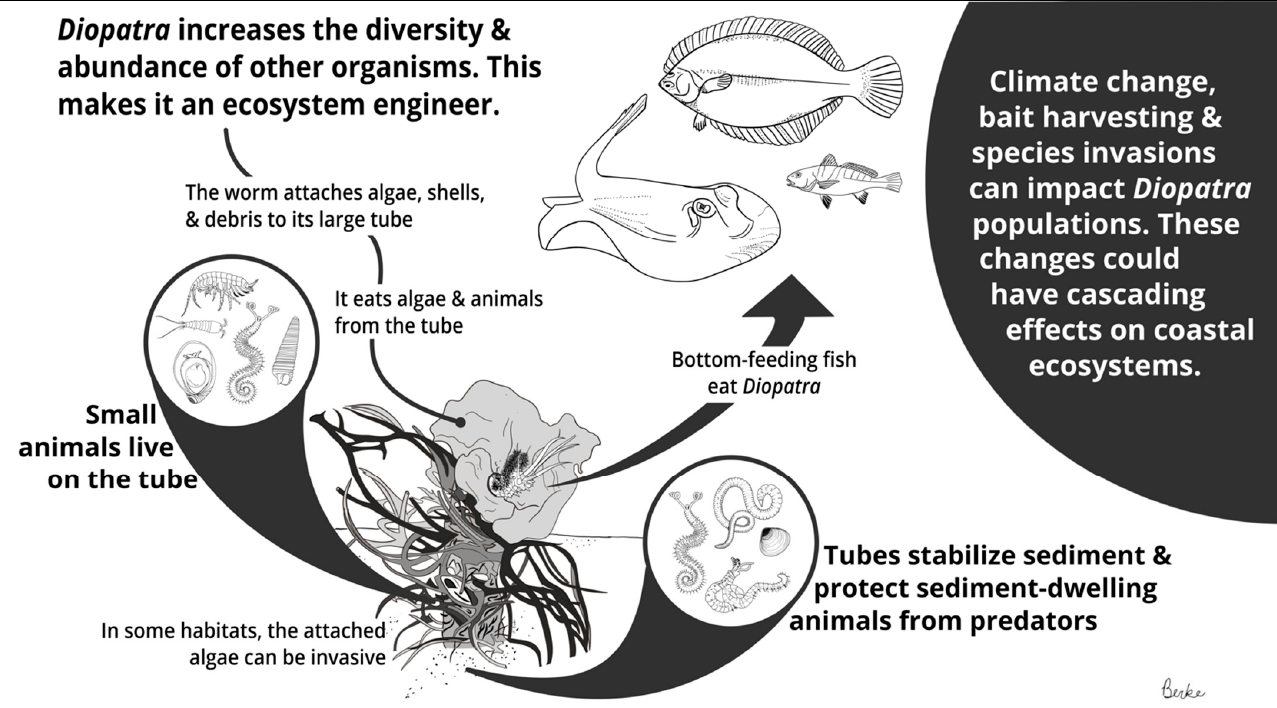
Figure 1. Summary of Diopatra ecological interactions. Taxonomic